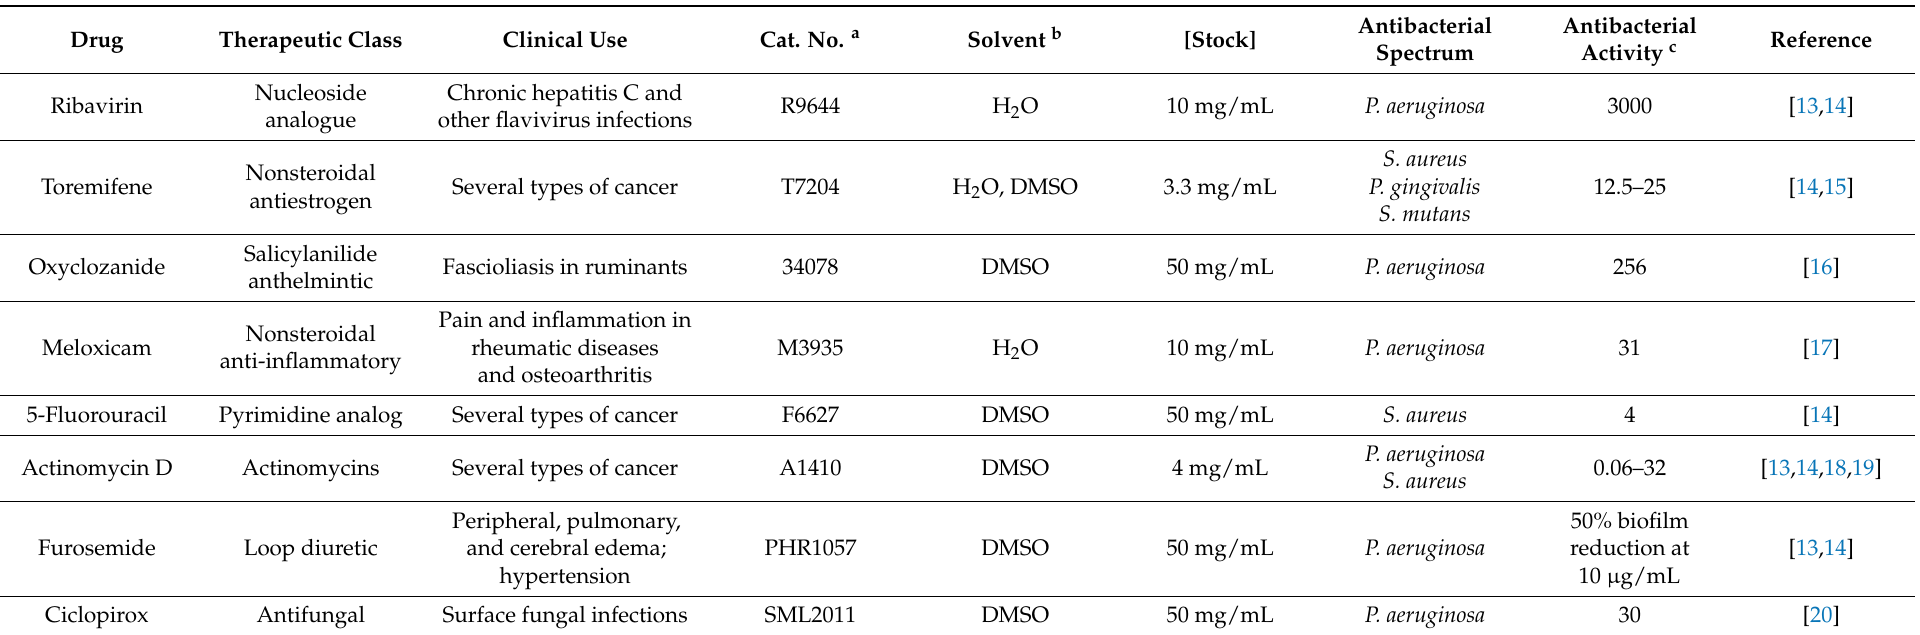
Table 1. FDA-approved “non-antibiotic” drugs tested. We selected some in-use pharmaceuticals found to have some direct antimicrobial effects in previously published